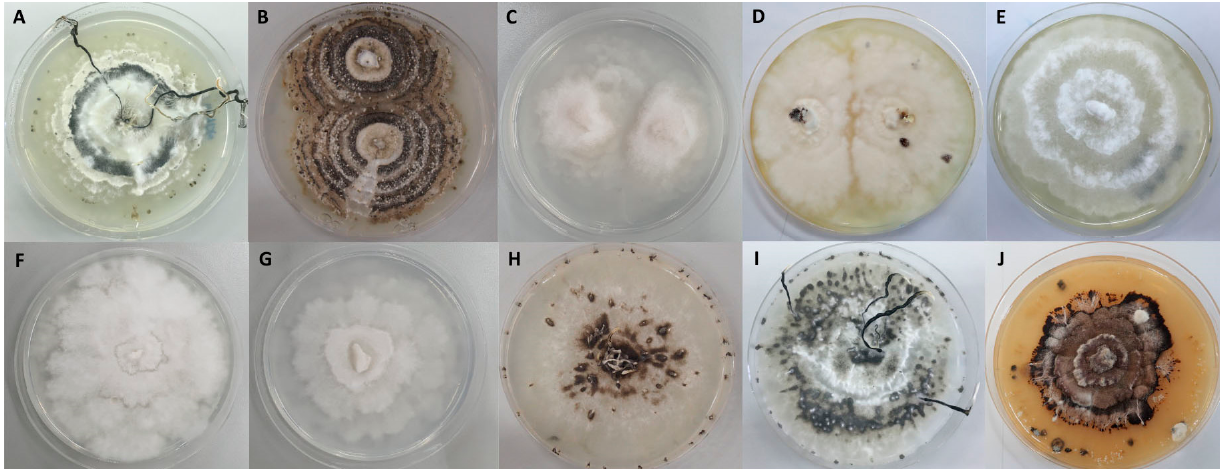
Figure 1. Cultures of Xylaria species associated with termite nests on PDA for extraction. ( A ) X. subintraflava SWUF16-11.1. ( B ) X. subintraflava SWUF17-24.2. ( C ) X. siamensis SWUF17-20.2. ( D ) X. chaiyaphumensis SWUF17-49.2. ( E ) X. chaiyaphumensis SWUF16-4.1. ( F ) X. chaiyaphumensis SWUF16-11.4. ( G ) X. thienhirunae SWUF16-44.1. ( H ) X. thienhirunae SWUF16-10.1. ( I ) X. thienhirunae SWUF16-7.2. ( J ) X. vinacea SWUF18-2.3.